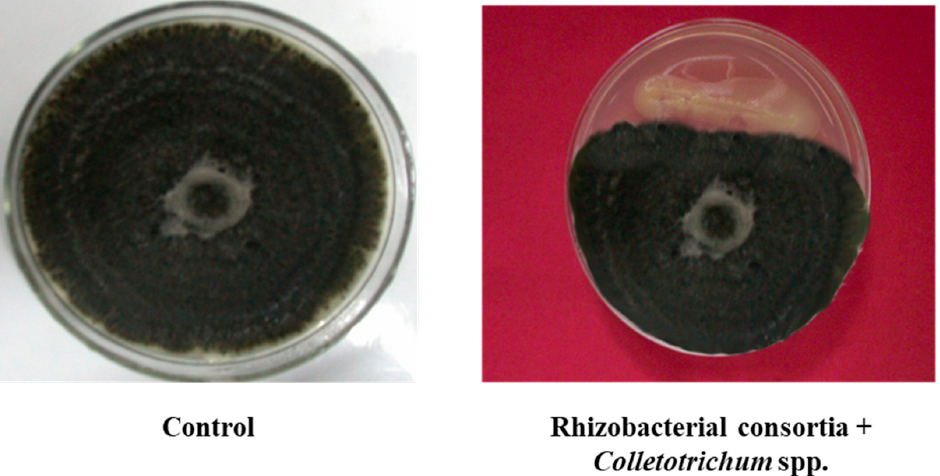
Figure 1. Growth inhibition of mycelia Phytophthora capsici and Colletotrichum sp. by rhizobacterial consortium.